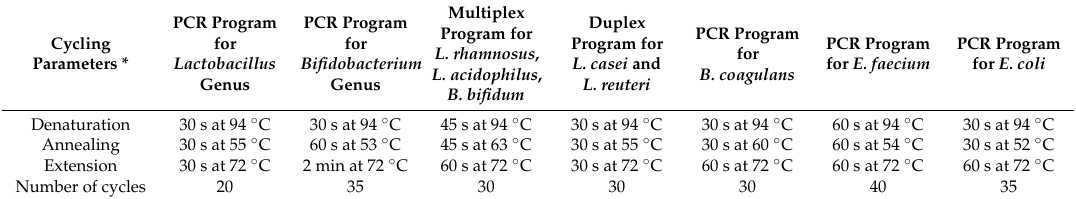
Table 3. Cycling parameters for polymerase chain reaction programs of selected